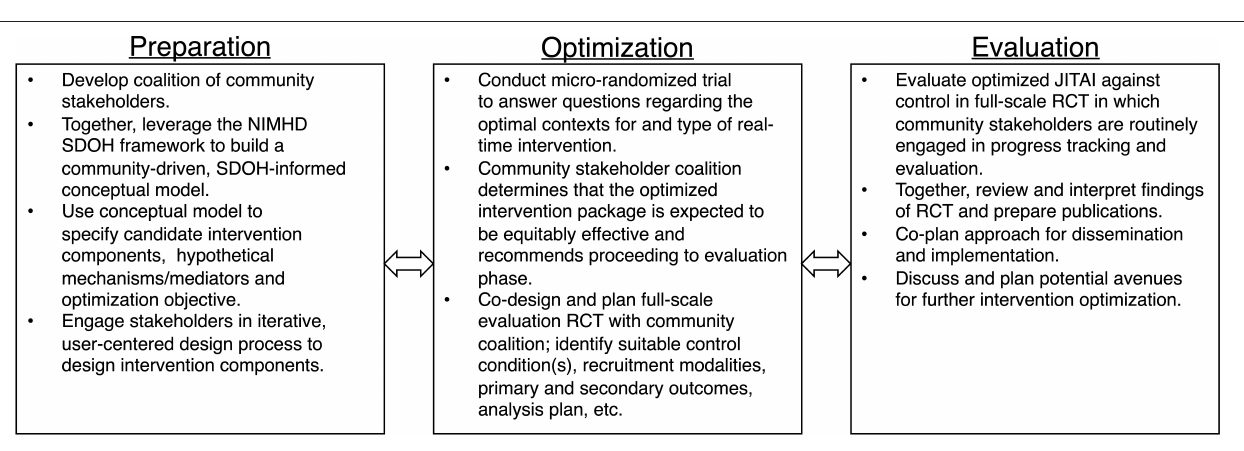
FIGURE 2 | Hypothetical application of proposed conceptual model using the multiphase optimization strategy